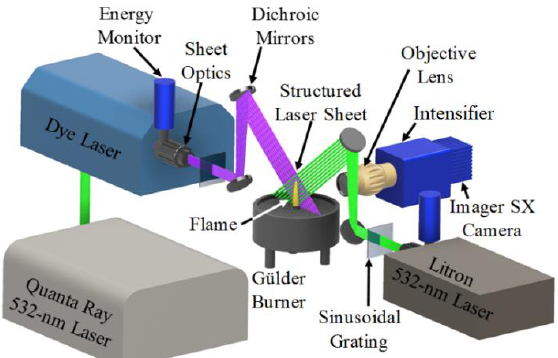
Figure 2. Schematic of the FRAME setup: two pulsed laser sources are converted into laser sheets and aligned in cross-illumination configuration using dichroic mirrors. Two custom made sinusoidal gratings of 10 line-pairs/mm create the spatial modulation. An optical filter, UV objective, intensifier and sCMOS camera are used for simultaneous LIF and LII imaging in ethylene/air diffusion flames of a Gülder burner.